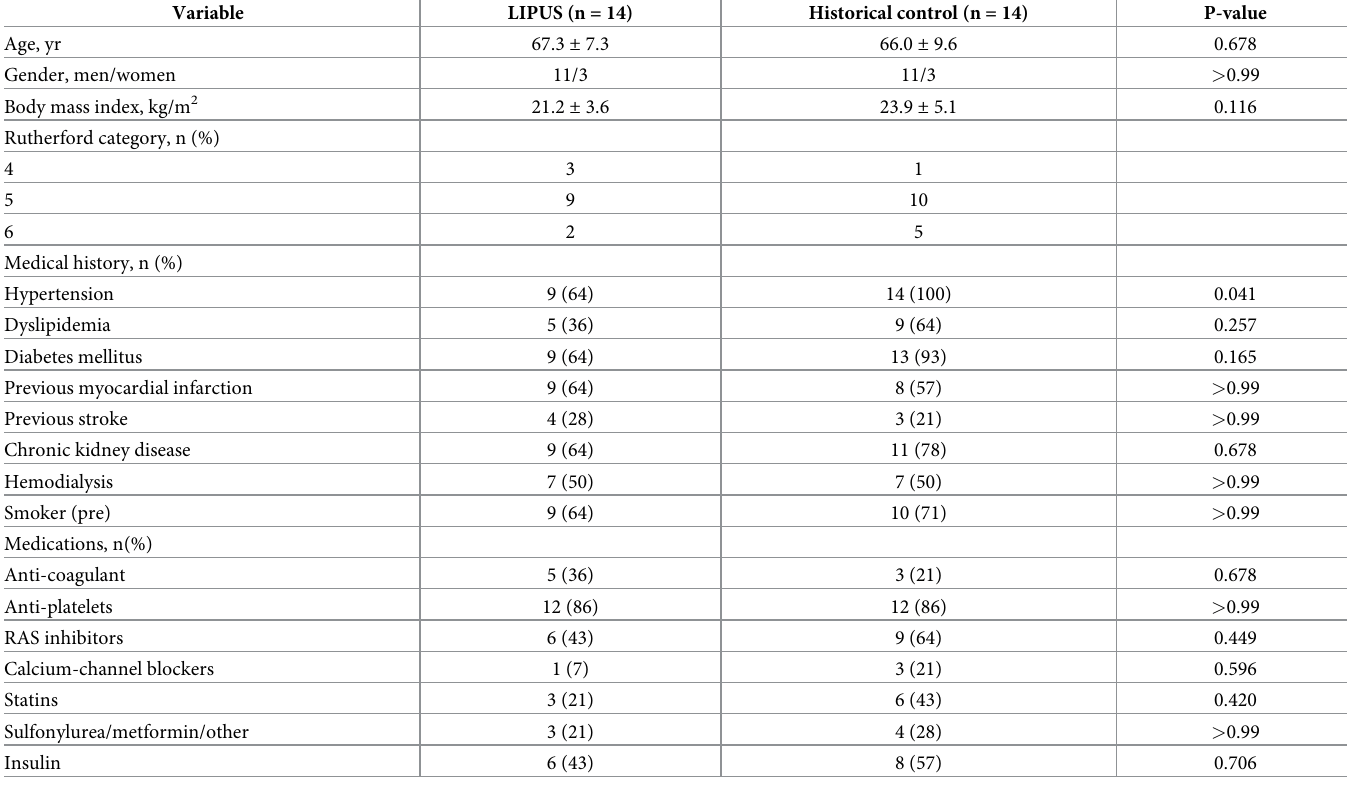
Table 1. Clinical characteristics of patients with CLI who were treated with LIPUS and historical